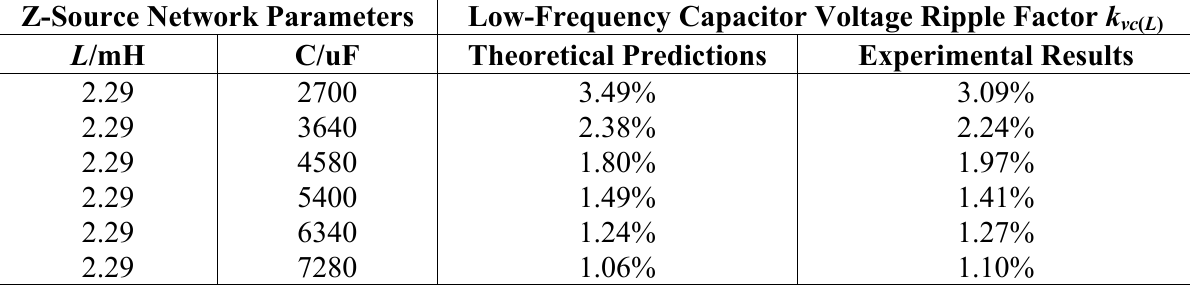
Figure 8. Comparison between theoretical predictions and experimental results.